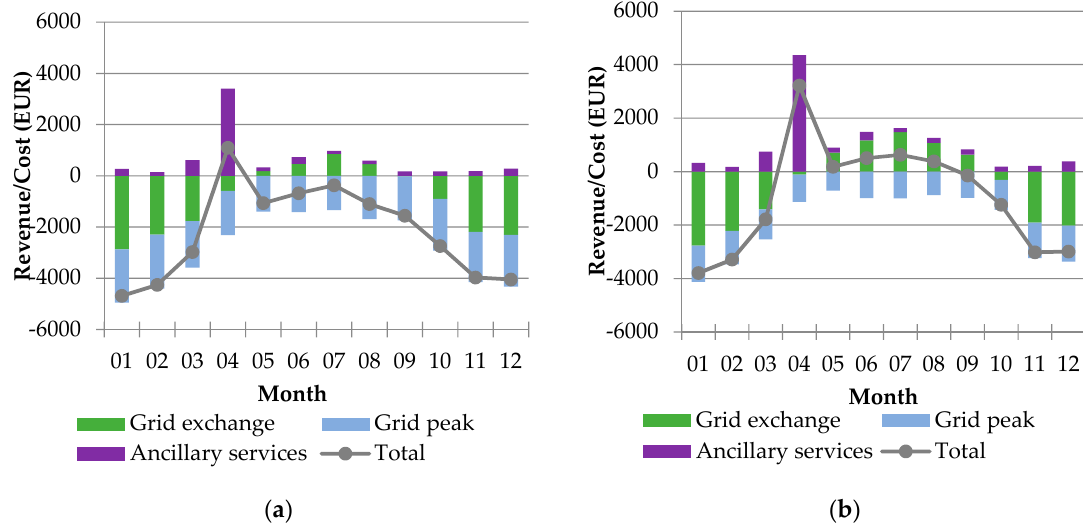
Figure 5. Monthly revenue/cost results: ( a ) Baseline including reserve market; ( b ) battery scenario including reserve market.